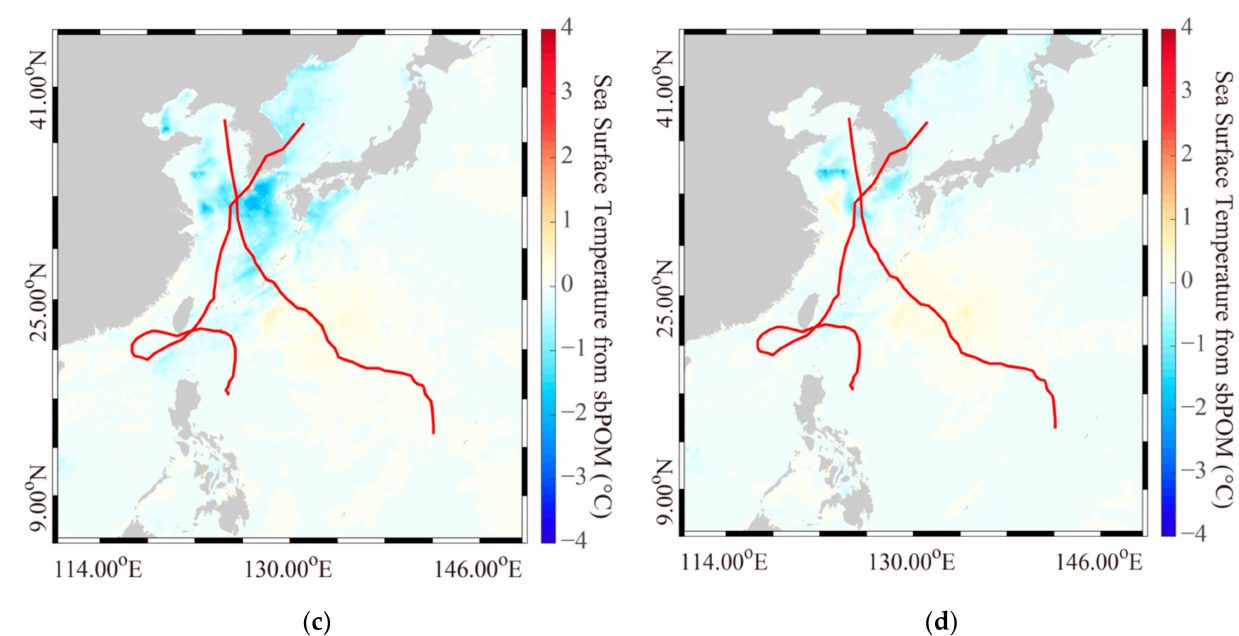
Figure 9. Daily average SSTs simulated using the sbPOM during Typhoons Tembin and Bolaven (26–30 August 2012). ( a ) Results from 26 July minus results from 27 July; ( b ) results from 27 July minus results from 28 July; ( c ) results from 28 July minus results from 29 July; ( d ) results from 29 July minus results from 30 July.